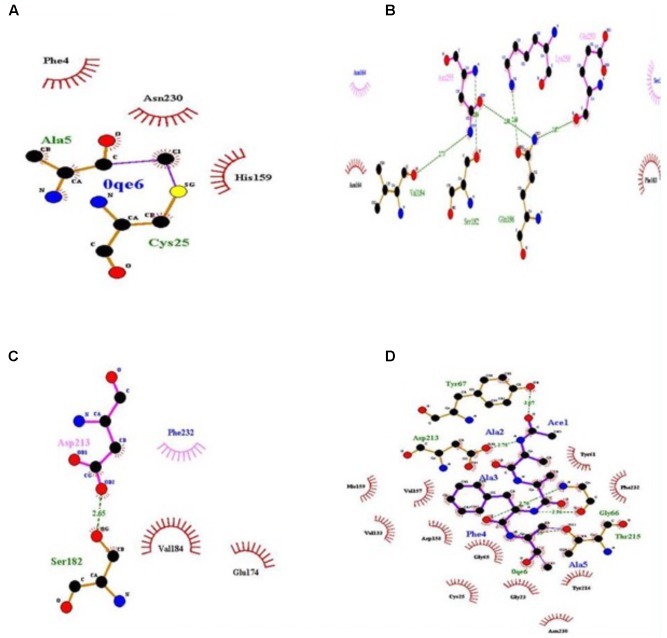
Docked complex showing interactions between cysteine protease and inhibitor (A) Cystatin A, (B) Cystatin C, (C) Cystatin S, (D) Papain.